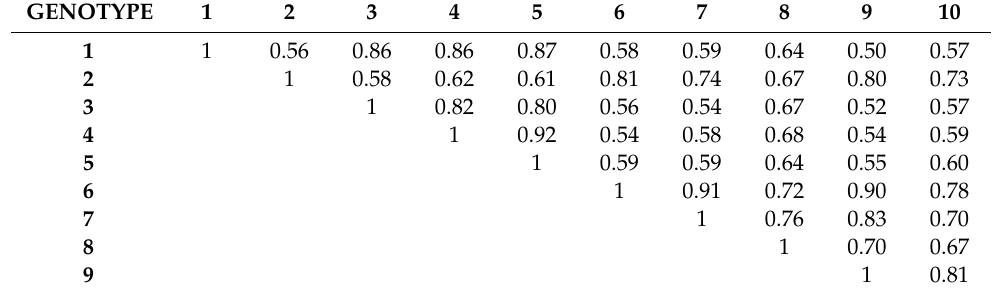
Table 4. Genetic similarity estimated among 10 stevia genotypes, based on RAPD markers calculated by Dice’s coe ffi cient.